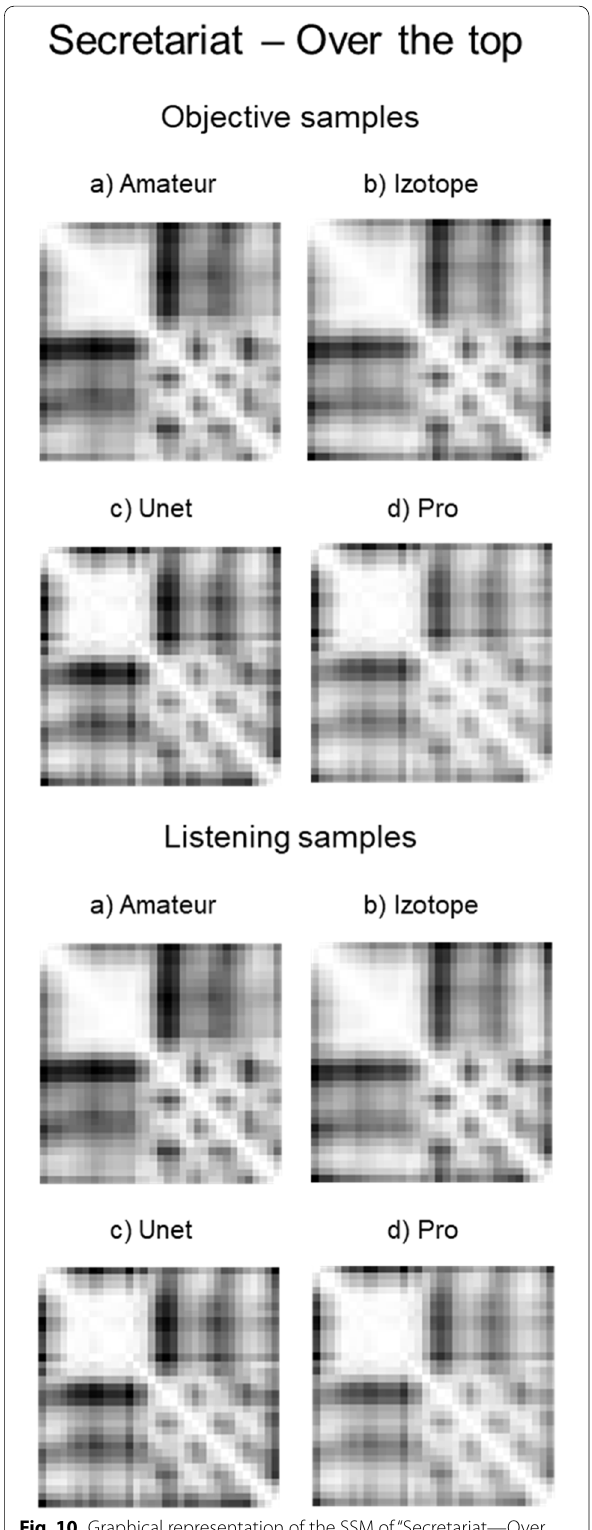
Fig. 10 Graphical representation of the SSM of “Secretariat—Over the top” objective and subjective